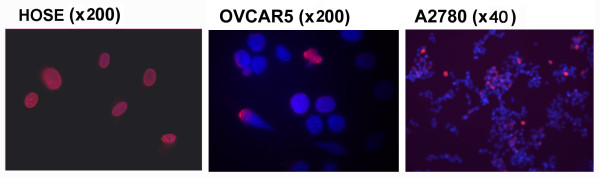
Heterogeneous lamin A/C expression in ovarian cancer cells. Lamin A/C expression in ovarian normal and cancer epithelial cells was analyzed by immunofluorescence microscopy for DAPI (blue) and lamin A/C (red). Primary ovarian surface epithelial (HOSE) cells exhibit a uniform staining pattern for lamin A/C. All ovarian cancer cell lines show heterogeneous staining of lamin A/C within the cell population, as shown in examples, the OVCAR5 and A2780 ovarian cancer cells.